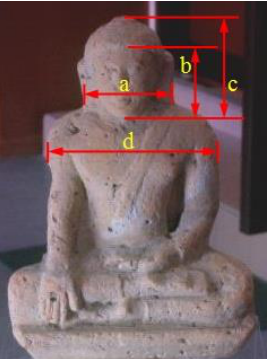
Figure 12. Measurement involved in the